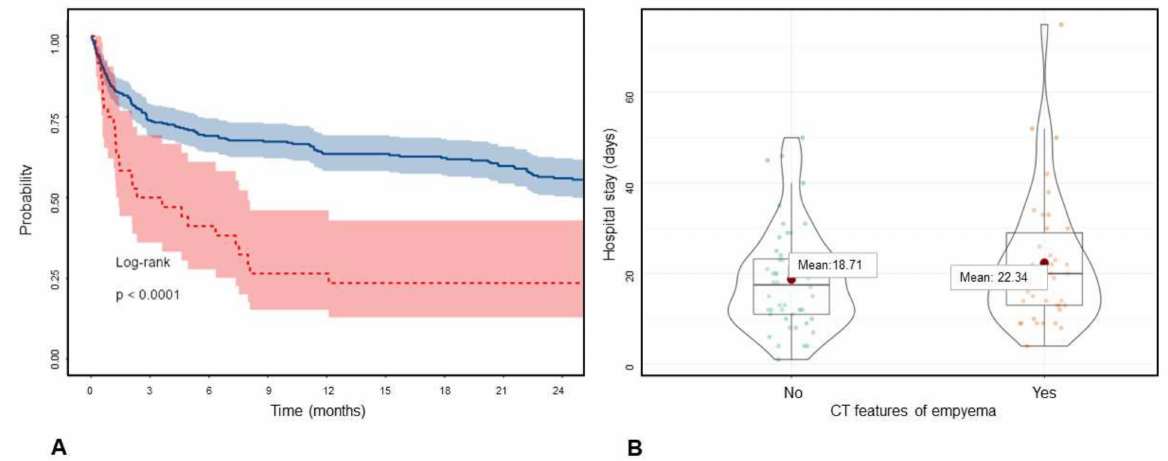
Figure 4. ( A ). Survival of the patients with (red) and without (blue) CT features of pleural carci- nomatosis based on Kaplan-Meier survival analysis. ( B ). Hospitalization duration in pneumonia patients with and without CT features of empyema.